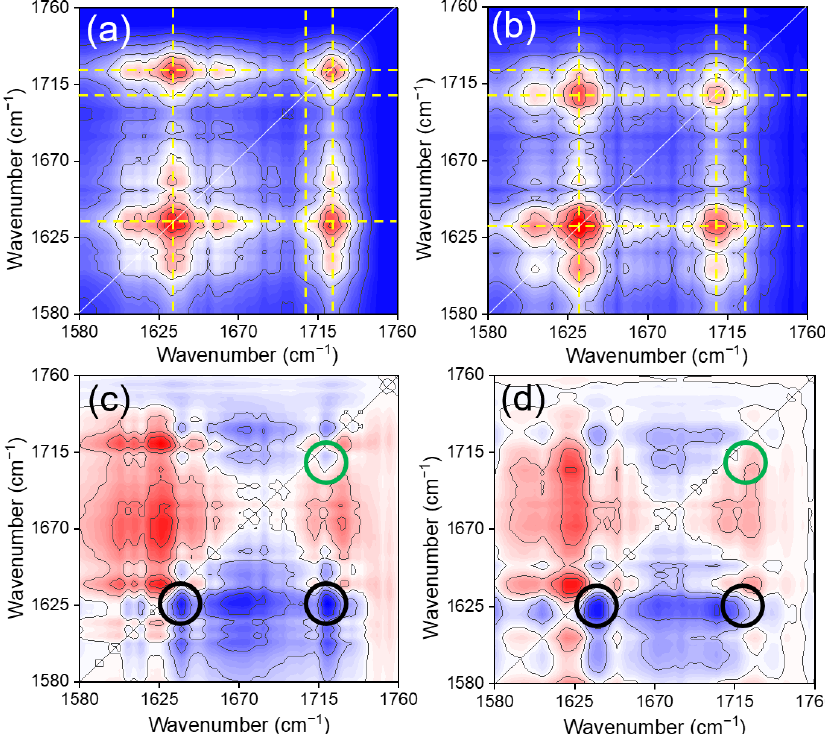
Figure 5. 2DSM and 2DAM for the Coum/SBE-β-CD inclusion complex (( a ) and ( c ), respectively), and corresponding physical mixture (( b ) and ( d ), respectively), in the 1580–1760 cm −1 wavenumber range. In the case of 2DSMs, positive cross-correlation intensities ( Φ(𝜈 1 ,𝜈 2 ) > 0 ) are marked in red, while null ones in blue ( Φ(𝜈 1 , 𝜈 2 ) = 0 ). On the other side, in 2DAMs, red, blue and white colored regions account, respectively, for positive, negative and null cross-correlation intensities. Yellow dashed lines are guide for the eyes. The green circle in panels ( c , d ) identifies the CP located at ~(1724,1712) cm −1 , while the black ones correspond to CPs located at ~(1637,1624) cm −1 and ~(1724,1624) cm −1 .